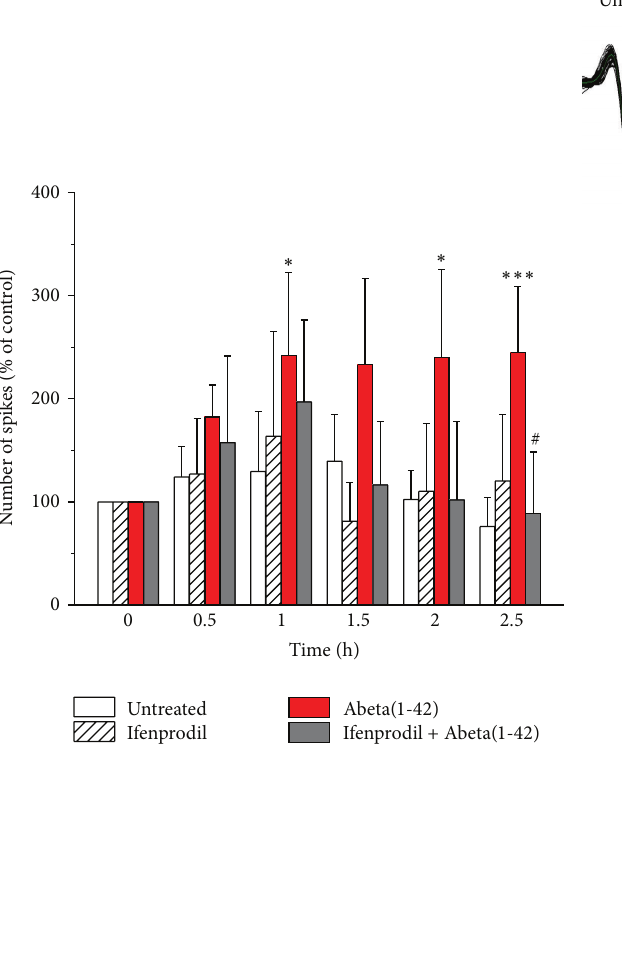
Figure 6: Abeta(1-42) induces hyperexcitation via NR2B. Abeta(1-42) induced increased spiking activity (untreated versus Abeta(1-42): 1h: ∗ 𝑃 = 0.043 ; 2 h: ∗ 𝑃 = 0.036 ; 2.5 h: ∗∗∗ 𝑃 = 0.001 ; Mann-Whitney 𝑈 test). Ifenprodil did not affect spontaneous activity but prevented the elevated spiking rate caused by Abeta(1-42) (Abeta(1-42) versus ifenprodil + Abeta(1-42) 2.5 h, # 𝑃 = 0.038 ; Mann-Whitney 𝑈 test). Upper panel shows exemplar units from the respective recordings, while bottom panel illustrates representative spike trains. Error bars represent SEM; ∗ 𝑃 ≤ 0.05 ; ∗∗∗ 𝑃 ≤ 0.001 ; # 𝑃 ≤ 0.05